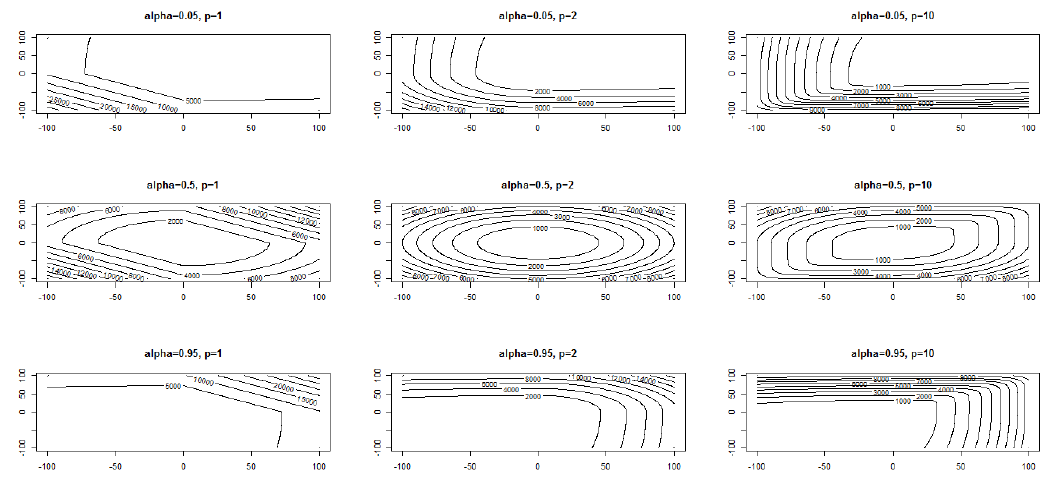
Figure 1: L p -expectile: Contour lines of the scoring function